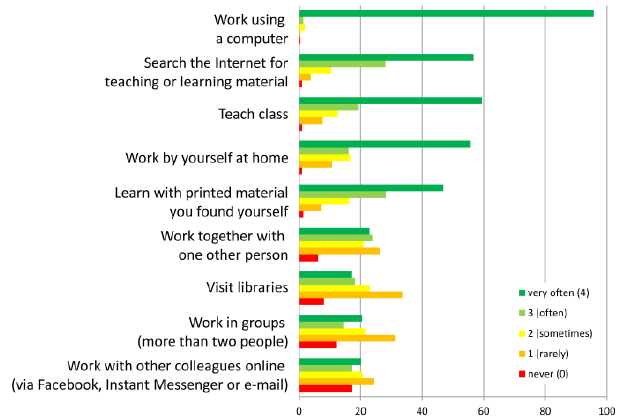
Figure 4. Valid percentage of instructors’ responses to